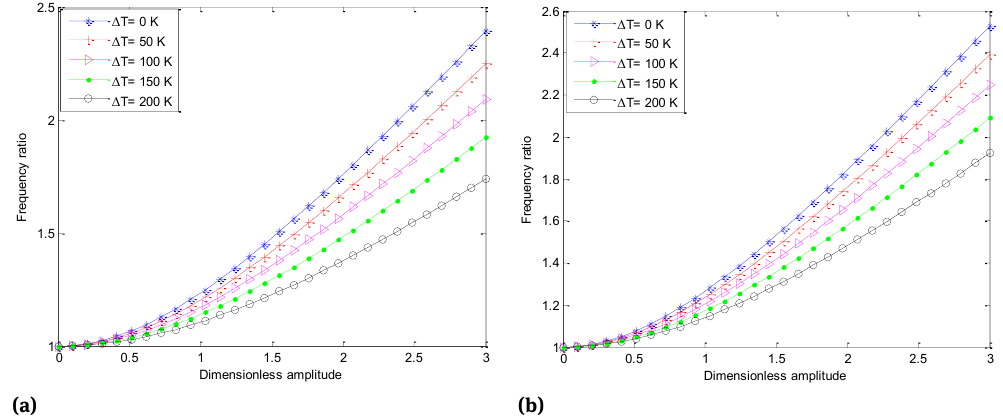
Figure 11: (a) Effects of temperature change on the frequency ratio for simply supported nanobeam (b) Effects of temperature change on the frequency ratio for clamped-clamped